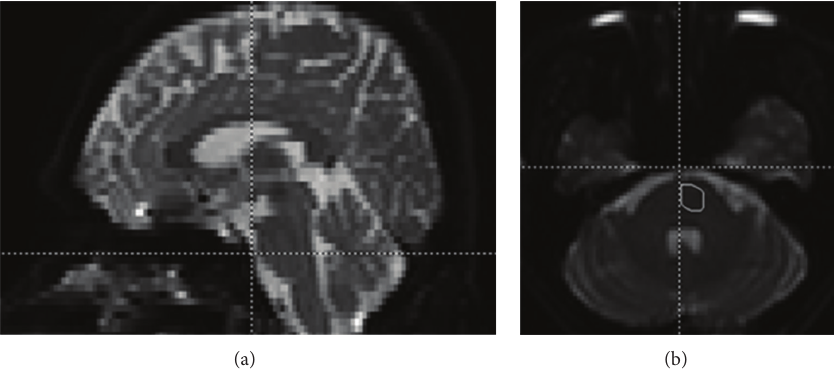
Figure 6: MRI data for the pons in the (a) sagittal and (b) axial planes. The rectangle in (b) was chosen as ROI to select the corticospinal tract (CST).